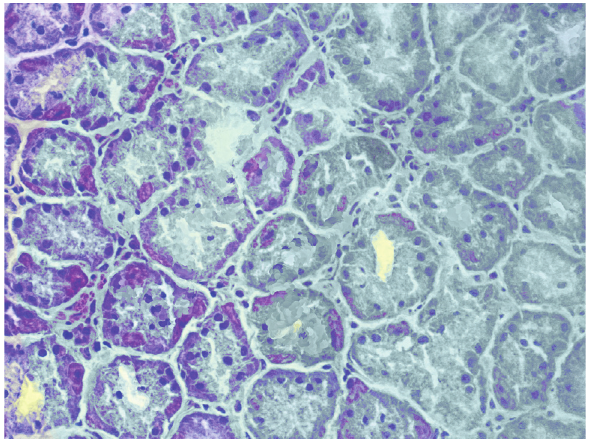
Figure 3 - Non-neoplastic gastric mucosa negative for COX-2 immu- noreactivity.